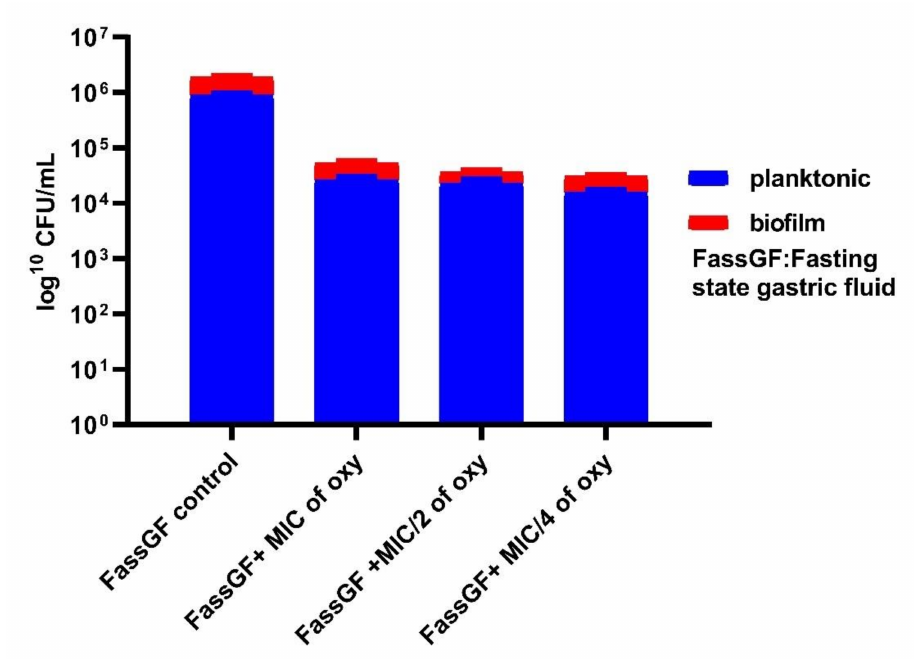
Figure 9. Viable counts (log CFU/mL) of L. fermentum ASBT-2 after 3 h of exposure to fasting state gastric fluid (FaSSGF).